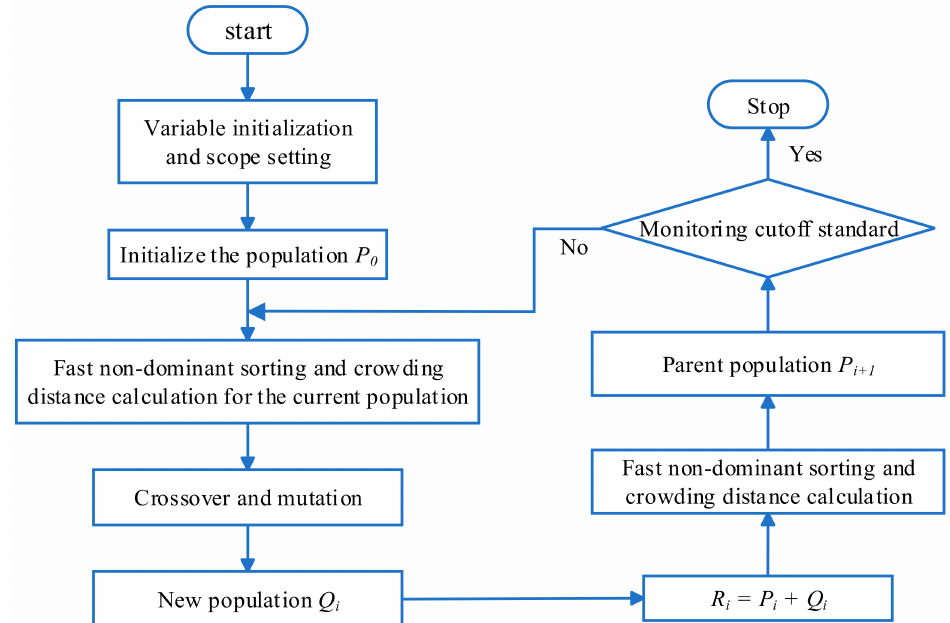
Figure 8. The flow chart of MOGA. (multi-objective genetic